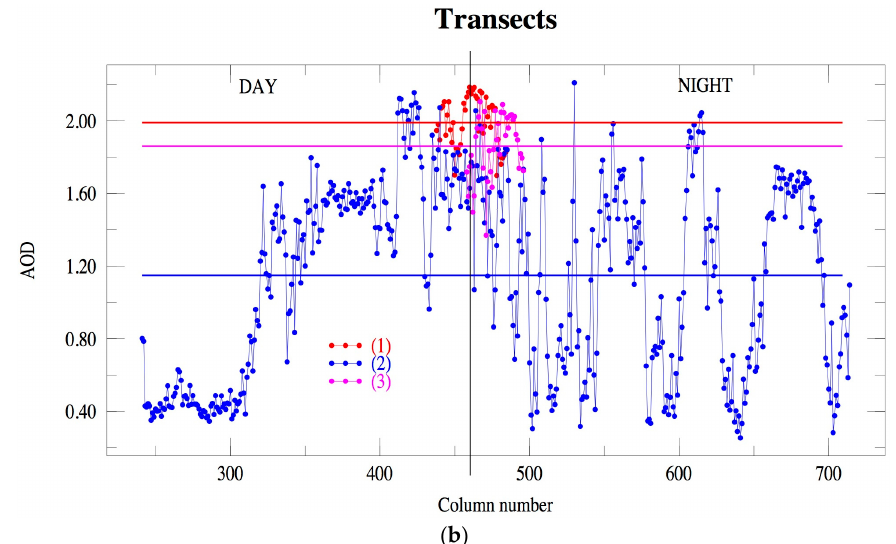
Figure 15. ( a ) Overview of day/night AOD retrievals on 9 March 2007; and ( b ) AOD profiles over three transects labeled (1), (2) and (3) across the day/night boundary; the horizontal lines correspond to the average values across the transect.